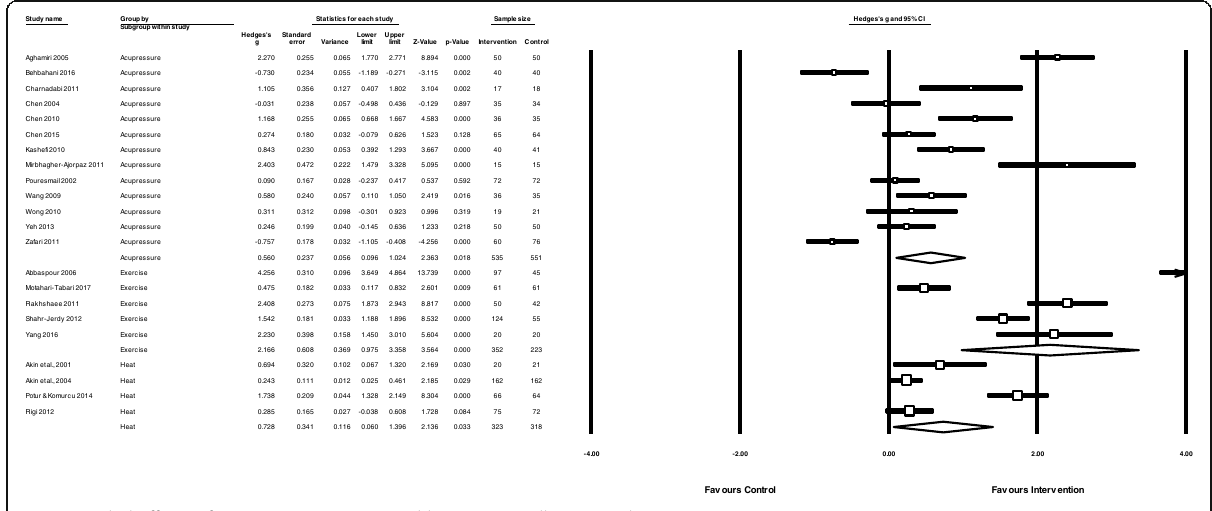
Fig. 4 Pooled effects of acupressure, exercise and heat on overall menstrual pain